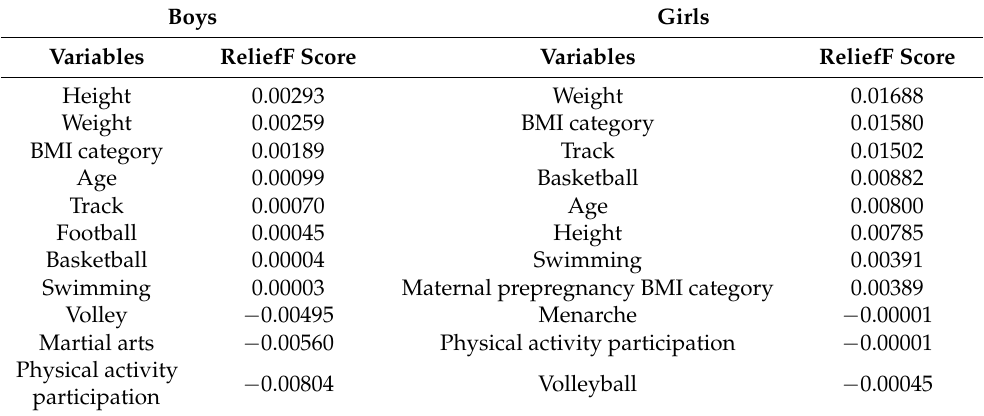
Table 1. Relief score of the independent variables and VO 2 max.